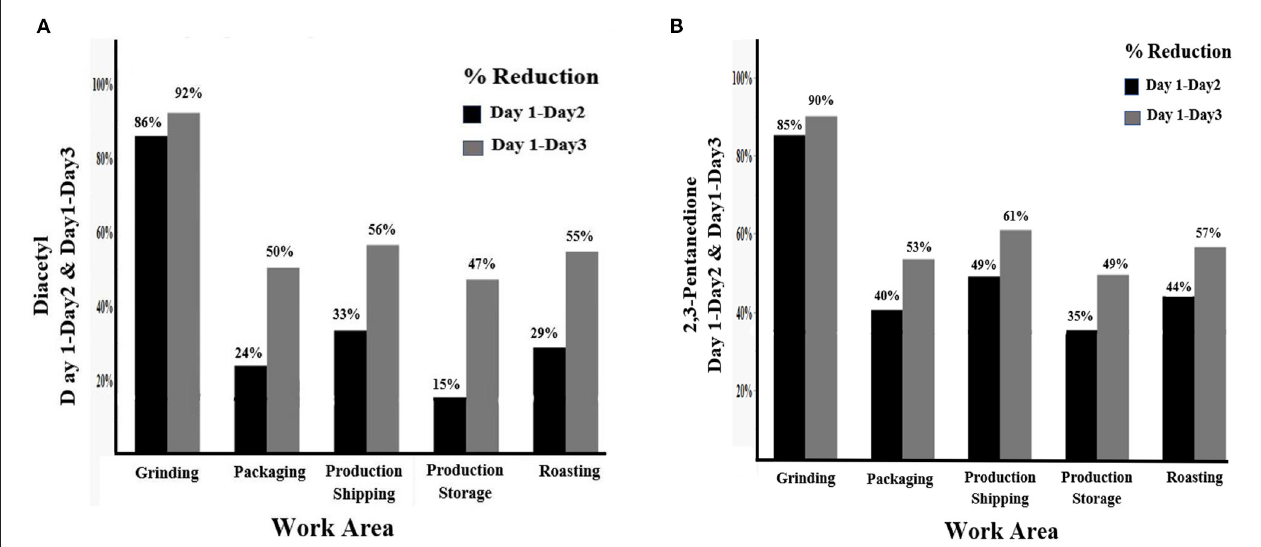
FIGURE 4 | Percent reduction in mean concentrations of (A) diacetyl and (B) 2,3-pentanedione by work area between Days 1 and 2 and Days 1 and